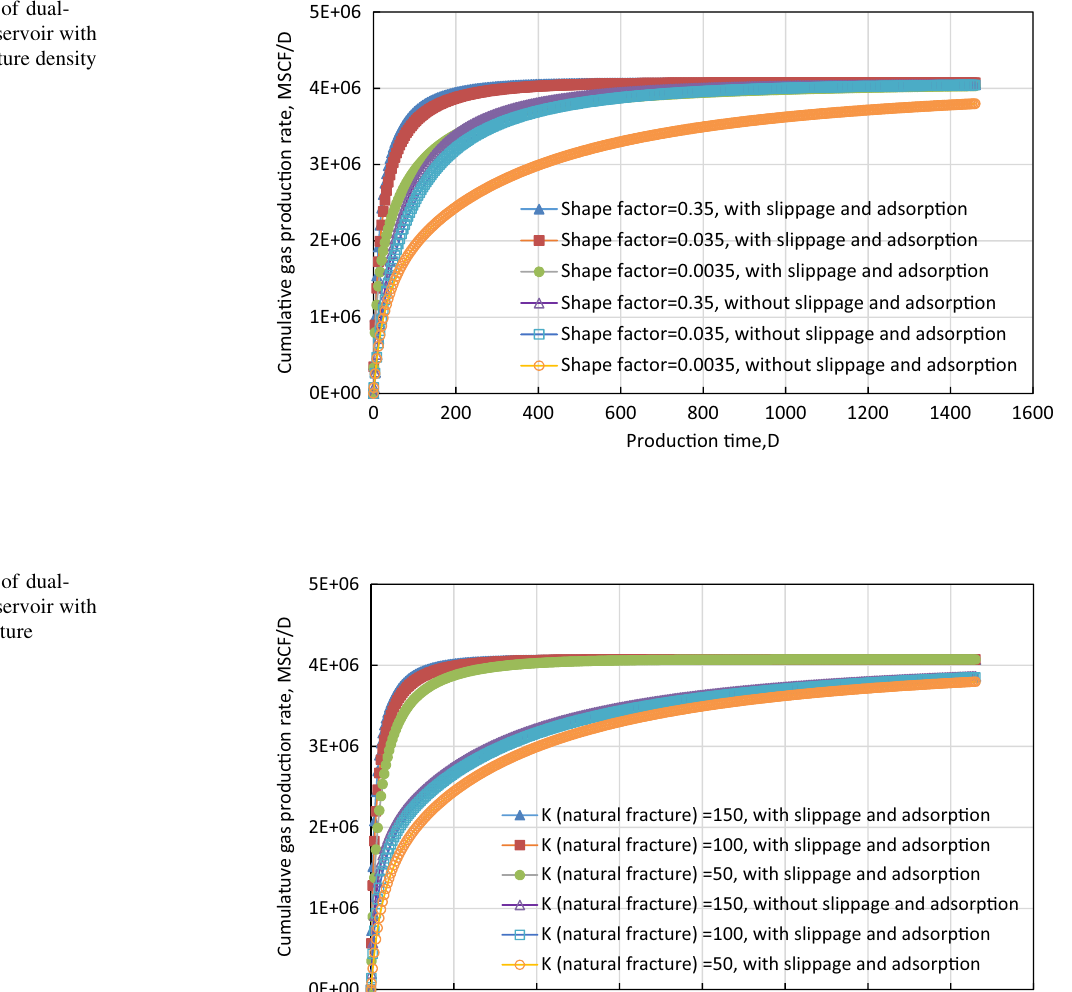
Fig. 6 Performance of dual-